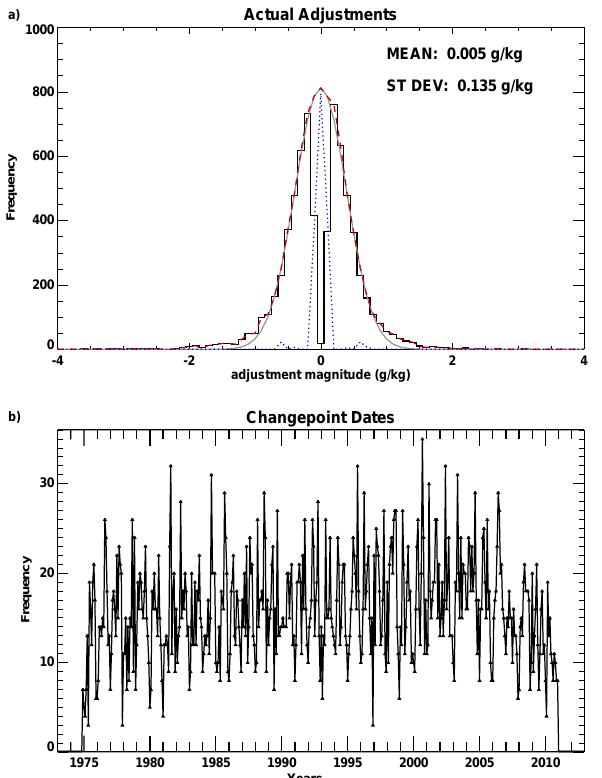
Fig. 3. Summary of adjustments applied to HadISDH during the pairwise homogenisation process. (a) Shows the actual adjustments in black (stepped). The best-fit Gaussian is shown in grey. The merged Gaussian plus larger actual distribution points “best fit” is shown in dashed red. The difference between the merged “best fit” and the actual adjustments is shown in dotted blue with the mean and standard deviation of the